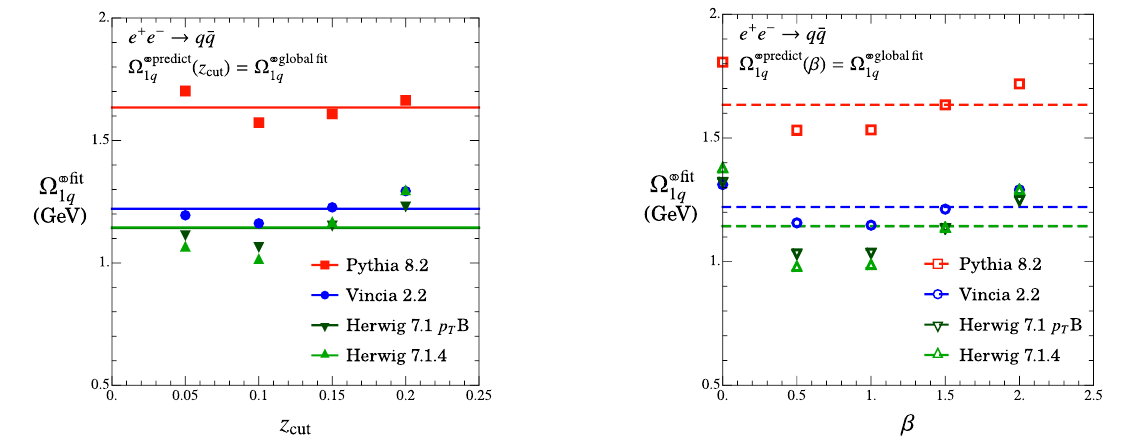
Figure 25 . Testing z cut and (cid:12) independence of (cid:10) (cid:14)(cid:14) comparing against the global (cid:12)t. The global (cid:12)t values of (cid:10) (cid:14)(cid:14) tunes and hence the green lines are on top of each